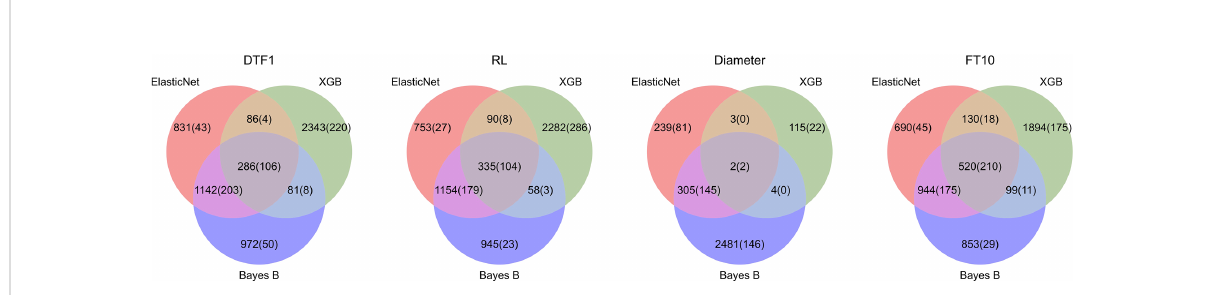
FIGURE 4 Comparison of feature importance of Elastic Net, Bayes B, and XGB with GWAS top 1,000 for Arabidopsis thaliana : For each phenotype, the corresponding Venn diagram shows the number of SNPs which were deemed important by one or more algorithms. A SNP is considered important if its related model parameter differs from zero in at least one of the outer folds in the nested cross-validation. The numbers of SNPs that were additionally within the top 1,000 GWAS results are shown in